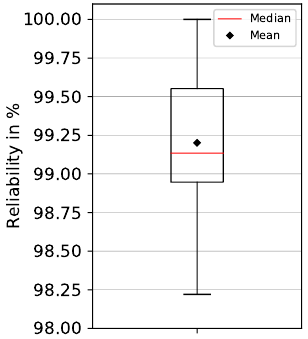
Figure 6. PUF reliability box plot.